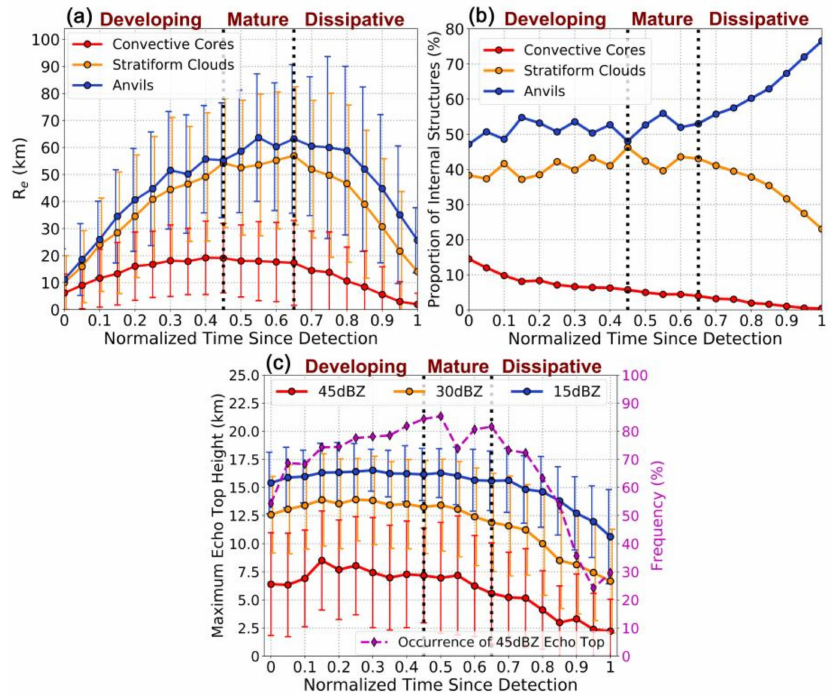
Figure 9. Line charts showing the variation in R e of ( a ) di ff erent MCS internal structures, ( b ) the proportions of internal structures with respect to the system as a whole, and ( c ) the maximum echo top height during the life cycle. The error bars represent standard deviations of the composite curves, while the dashed line in purple shows the variation in the probability of the maximum radar reflectivity reaching 45 dBZ (over northern China) as a function of